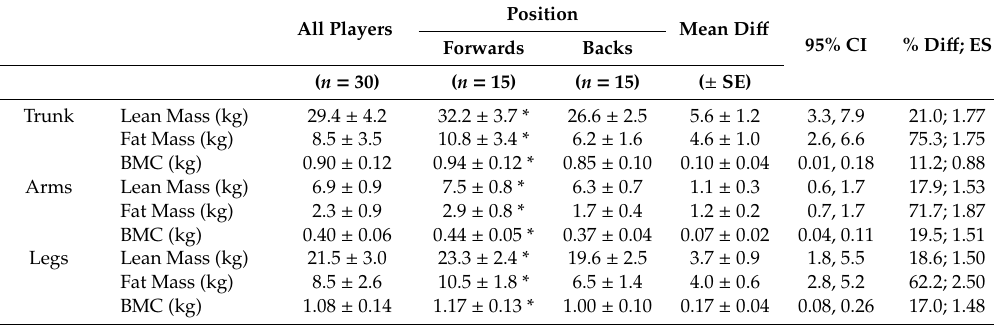
Table 2. Regional body composition characteristics of elite female RU